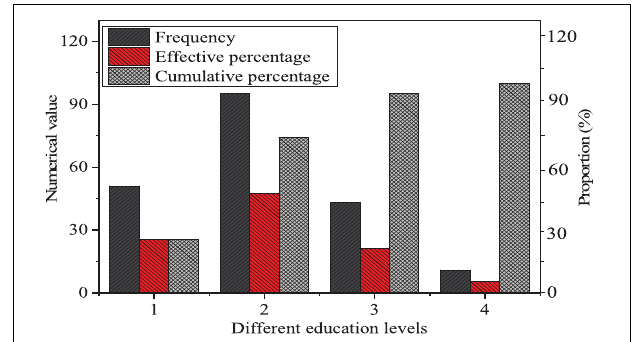
FIGURE 5 | Descriptive statistics of the educational levels of entrepreneurs (1: senior high school or below; 2: junior college; 3: undergraduate; 4: postgraduate and above).